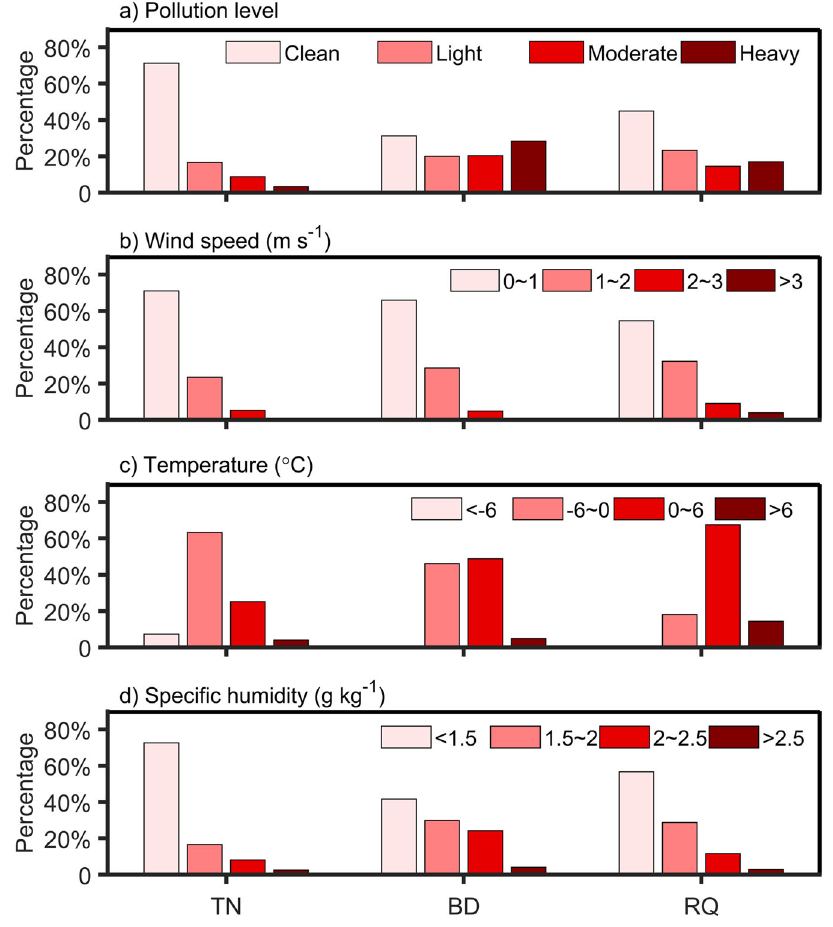
Fig. 3 Comparison of the pollution level and surface meteorological elements among Tuonan (TN), Baoding (BD), and Renqiu (RQ) stations during the whole observation period. a pollution level (clean represents the air quality is excellent or good; light, moderate and heavy represent three levels of pollution), ( b ) wind speed, ( c ) temperature, ( d ) speci fi c